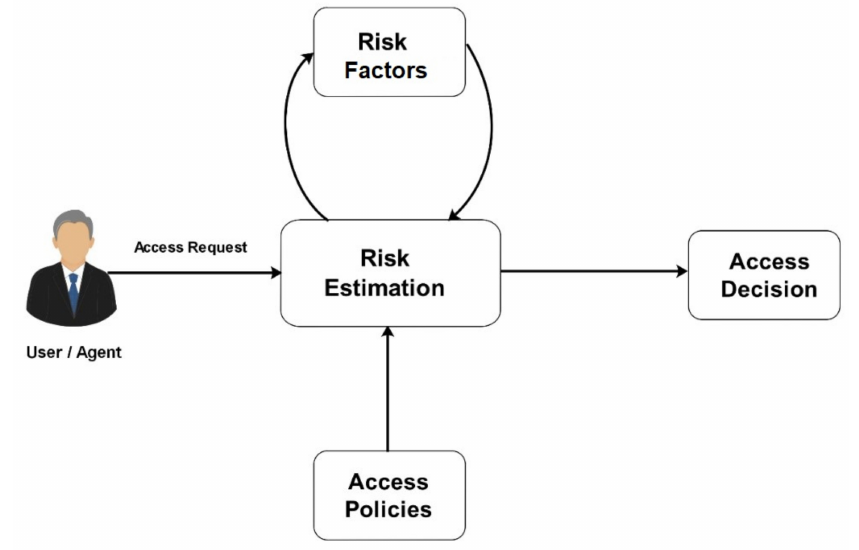
Figure 2. Main elements of a risk-based access control